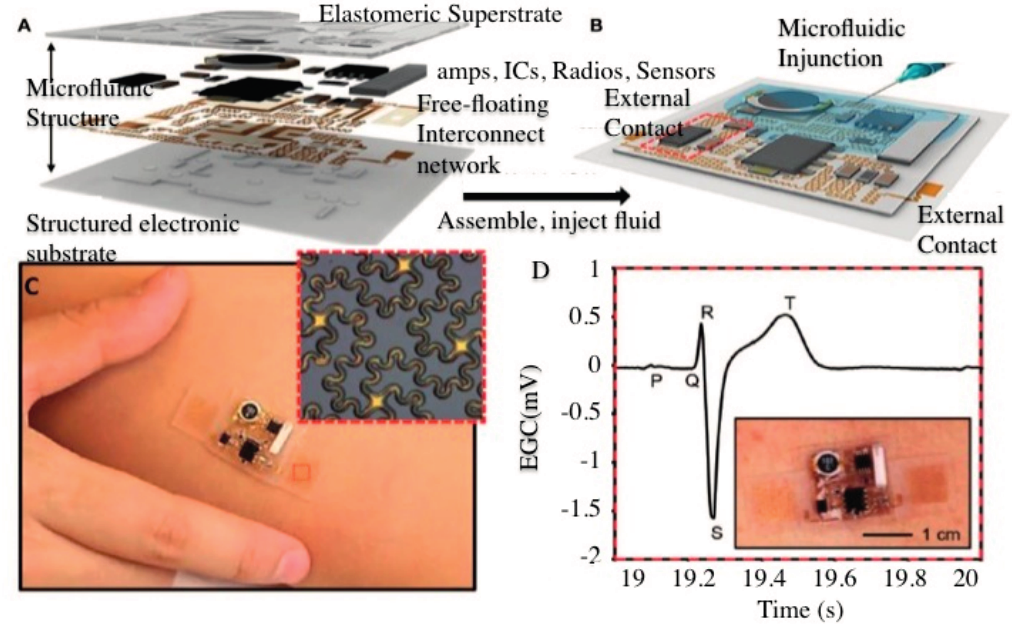
Figure 4. Novel soft elastomeric wireless wearable sensing system ( A – B ) schematics of structured elastomeric substrate with free-floating network; ( C ) photo of patched adhesive wearable system and ( D ) the ECG curve recorded with the wearable sensing system (Reproduced with permission from Science